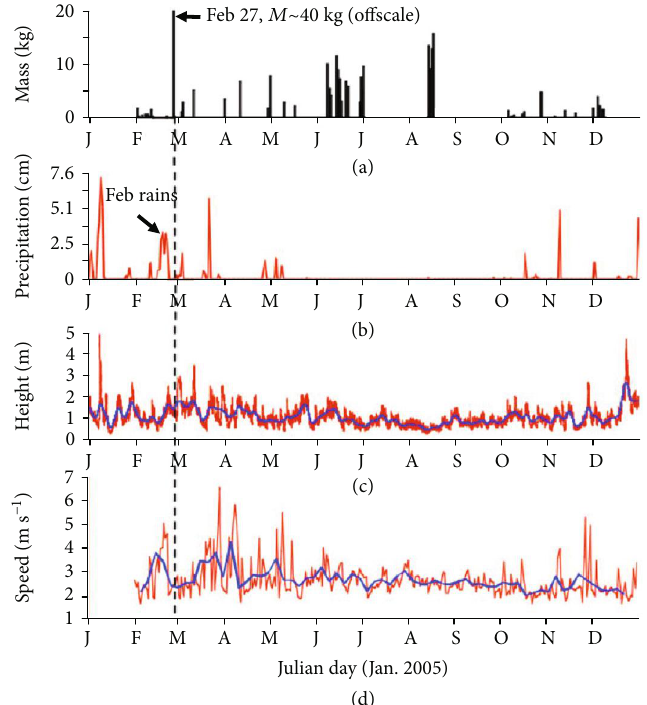
Figure 28: Beach study area tar (a) mass accumulation (M), (b) precipitation at West Campus Station, (c) swell height, and (d) daily and 5-day averaged wind speed. Adapted from Del Sontro